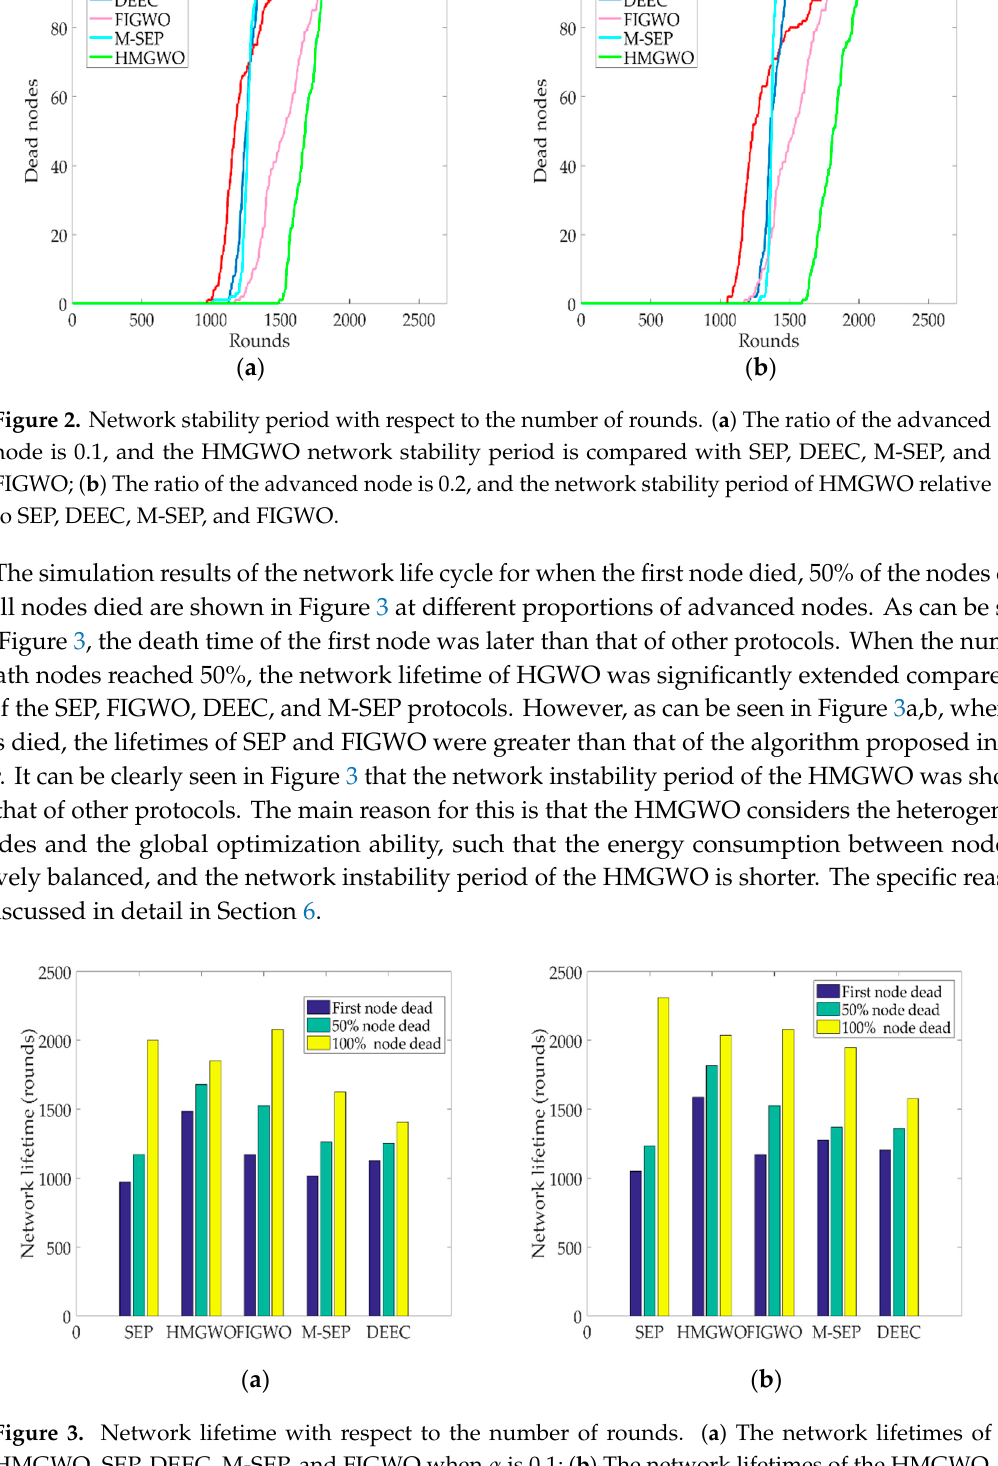
Figure 3. Network lifetime with respect to the number of rounds. ( a ) The network lifetimes of HMGWO, SEP, DEEC, M-SEP, and FIGWO when 𝛼 is 0.1; ( b ) The network lifetimes of the HMGWO, SEP, DEEC, M-SEP, and FIGWO when 𝛼 is